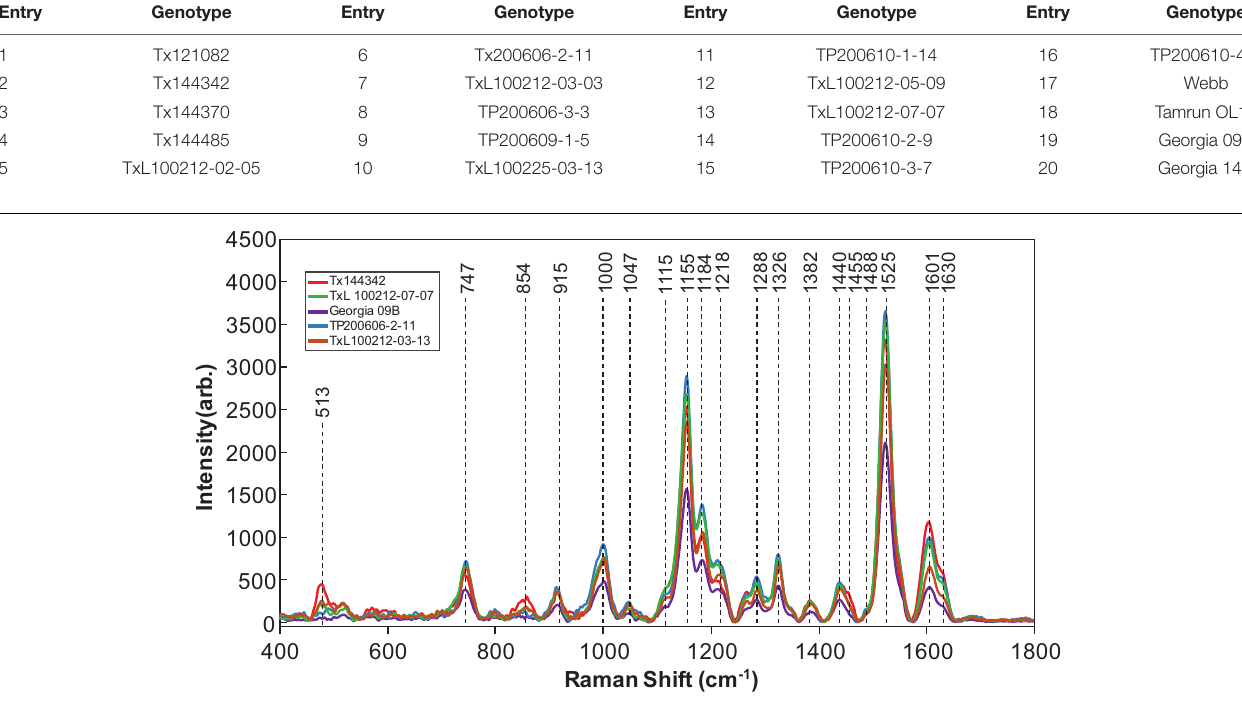
FIGURE 1 | Raman spectra collected from leaves of five representatives of peanut genotypes. In total, 19 peanut genotypes were